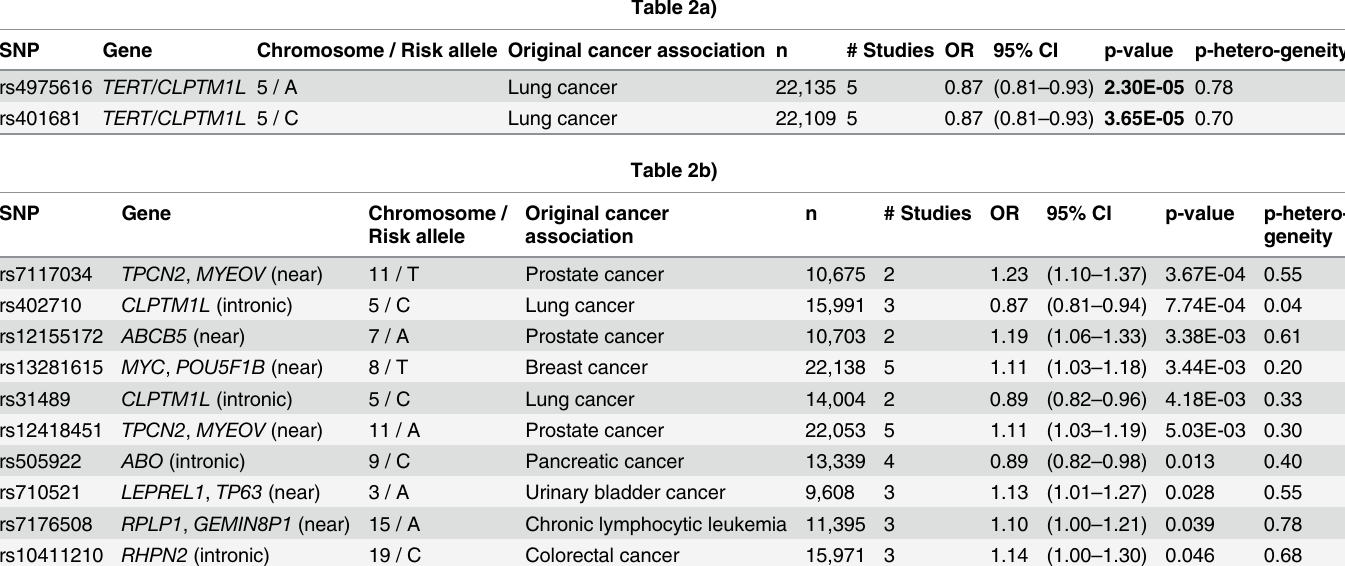
effects in opposite directions for different cancer types. Specifically, for both SNPs the allele as- sociated with an increased risk of lung cancer appears to also be associated with a decreased risk of melanoma.